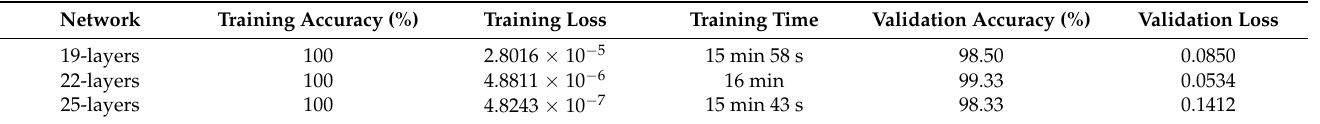
Table 3. Comparison of isolated-CNN models for binary-class classification (tumor and no tumor) using dataset I.